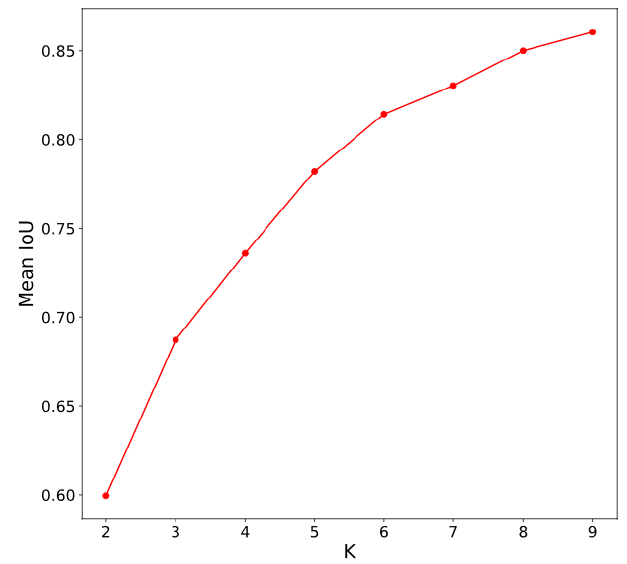
Figure 8. Mean IoU with respect to K for the optimal K determination.